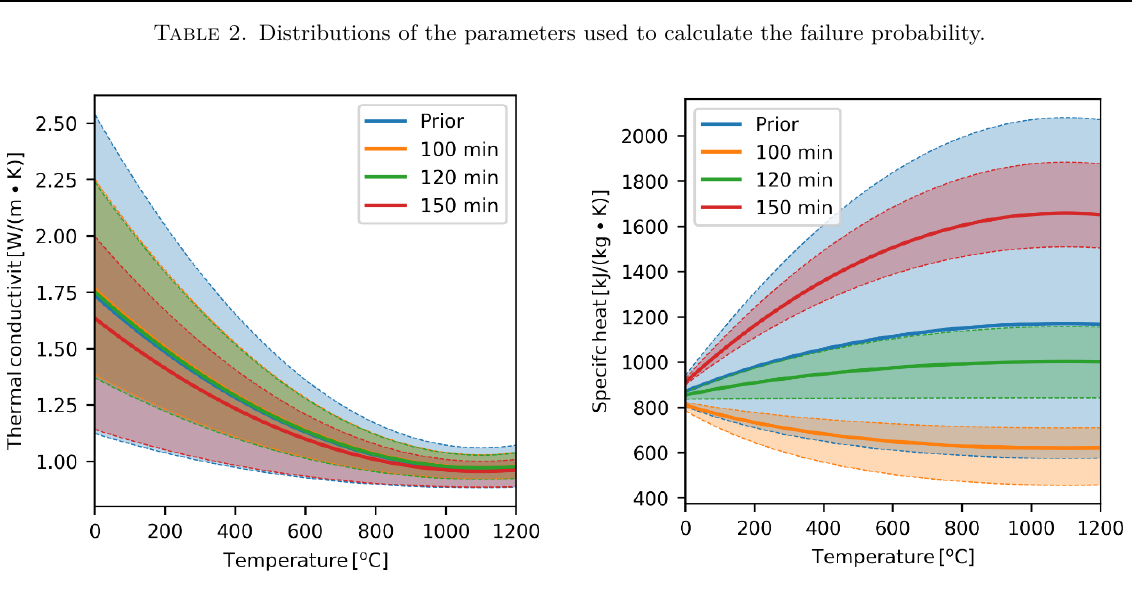
Figure 2. Posterior distributions for thermal conductivity (left) and specific heat of concrete (right) at different temperatures for different values of failure time with the shaded 90 % Highest Density Intervals